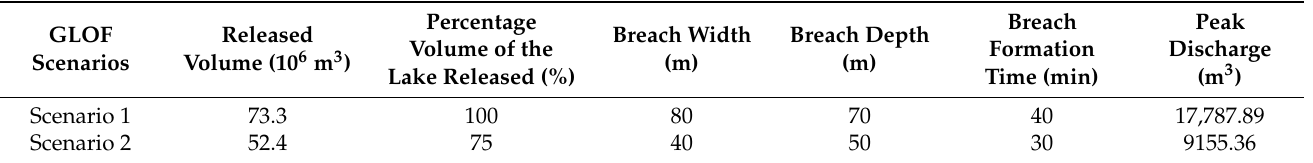
Table 3. Breach parameters calculated from Froehlich’s